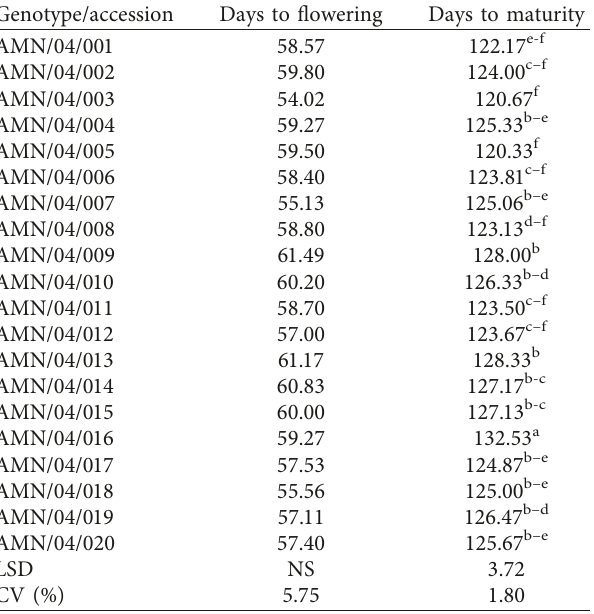
Table 2: Mean performance of genotypes of Bambara groundnut for phenological